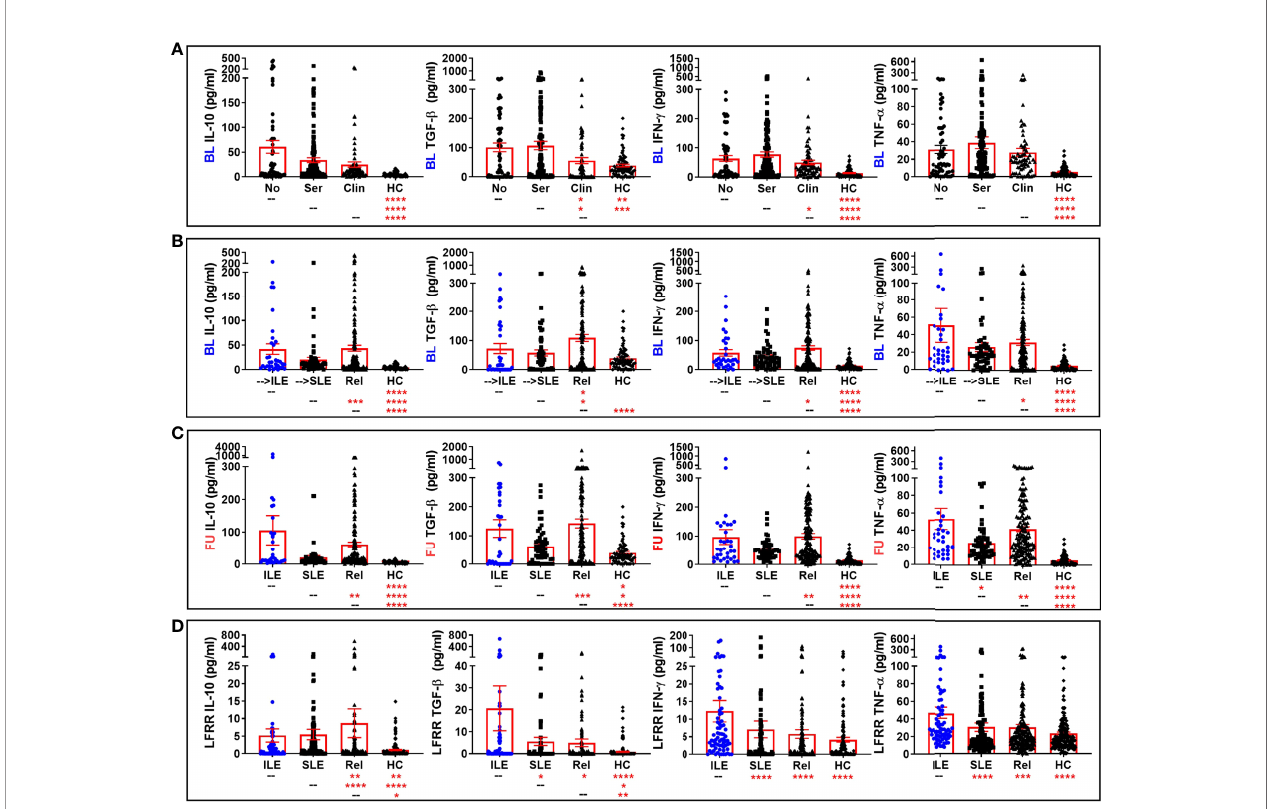
FIGURE 5 | Altered regulatory and select Th1-type mediators in lupus relatives who develop ILE or transition to SLE. Lupus relatives and matched, unaffected healthy controls (HC) were evaluated for plasma levels of evaluated for plasma levels of IL-10 ( 1 st column ), active TGF- b ( 2 nd column ), IFN- g ( 3 rd column ), and soluble TNF- a ( 4 th column ) in (A) LAUREL cohort at baseline meeting No ACR criteria (No), only serologic ACR criteria (Ser), or clinical ACR criteria (Clin) vs. matched, unaffected HC and (B – D) lupus relatives who developed ILE (ILE), transitioned to SLE (SLE), or remained clinically unaffected (Rel) vs. matched healthy controls (HC) in (B) LAUREL cohort at baseline (pre-transition), (C) LAUREL cohort at follow-up (post-transition), and (D) LFRR con fi rmatory cohort (post-transition). Mean ± SEM. **** p<0.0001 ; *** p<0.001 ; ** p<0.01 ; * p<0.05 by Kruskal-Wallis with Dunn ’ s multiple